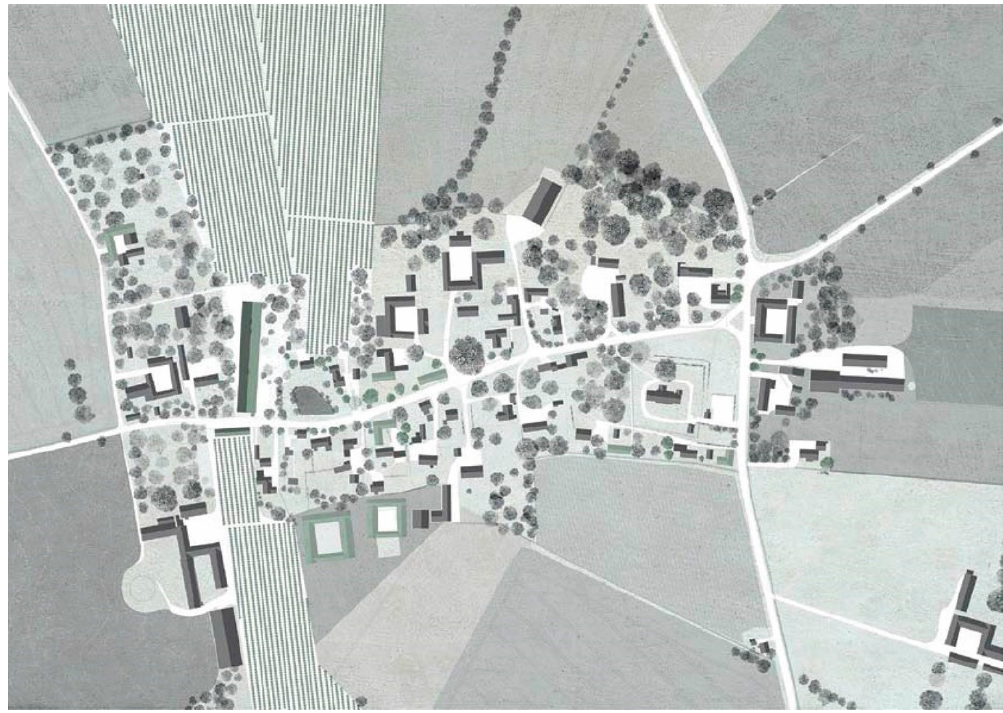
Figure 6. Plan of Høve with the suggested apple plantation and the production units in the central left part of the figure. The plantation fields spread out to the North and the South of the production unit.